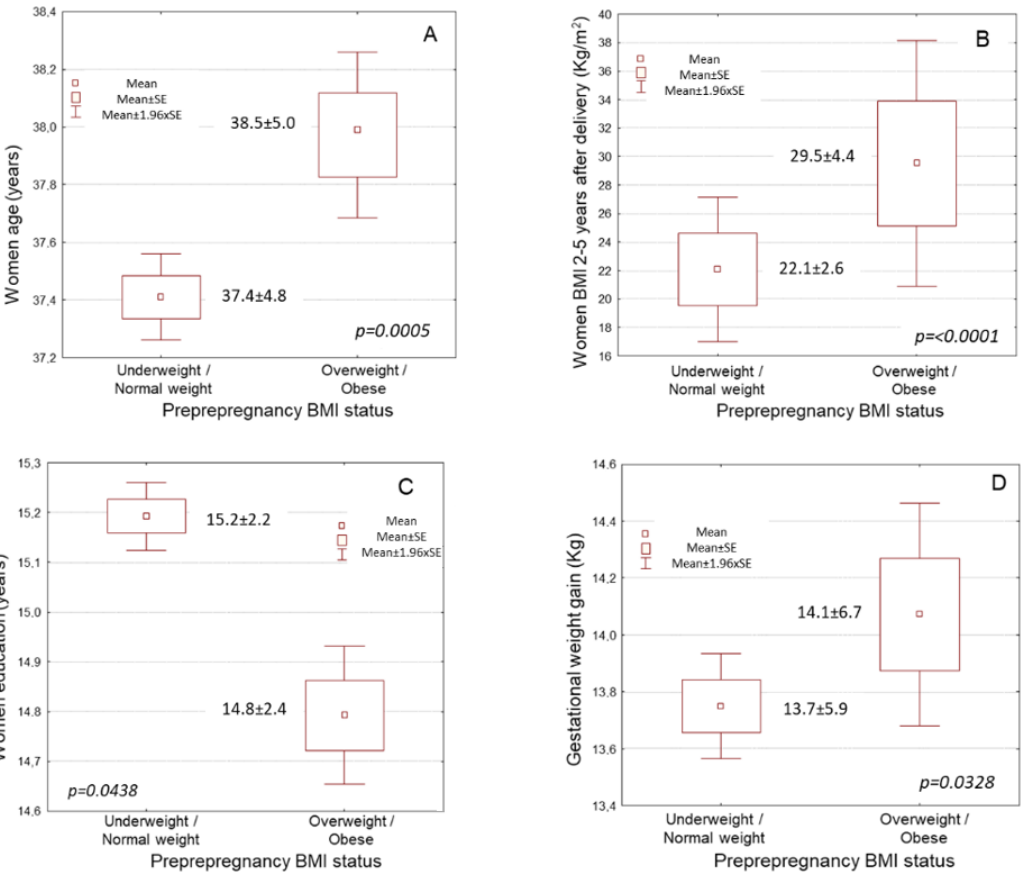
Figure 1. Associations of pre-pregnancy overweight and obesity with women: ( A ) Age, ( B ) Educa- tional level, ( C ) BMI 2–5 years after delivery and ( D ) Gestational weight gain. BMI, body mass index; SE, standard error.